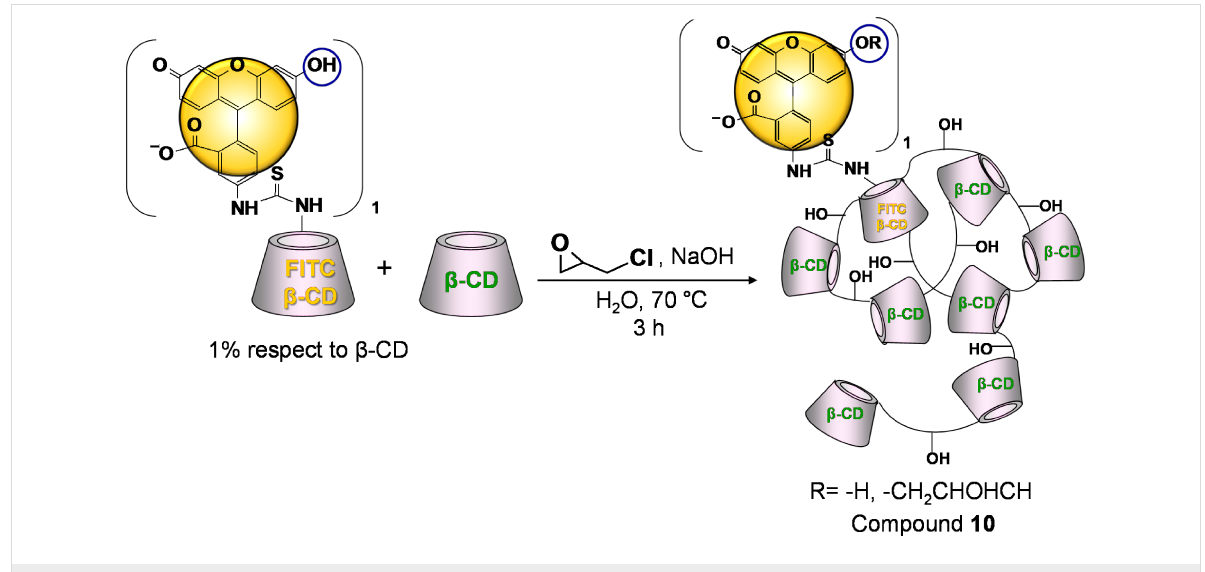
Scheme 5: Schematic representation for the introduction of fluorescein into a β